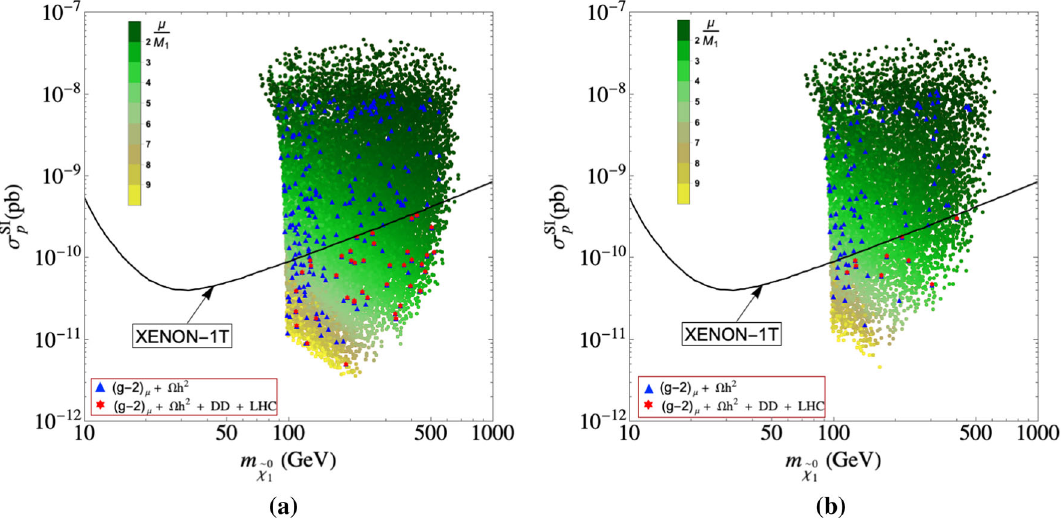
Fig. 13 The results of our parameter scan in the m ˜ χ 0 from ( g − 2 ) μ ). The color coding as in Fig. 4